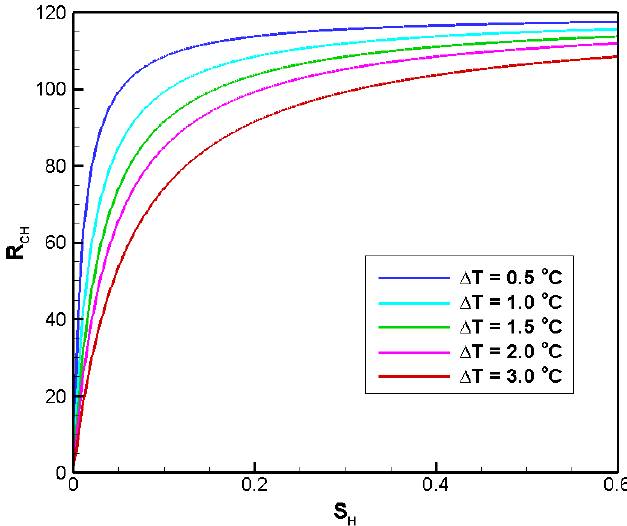
Figure 3. Dependence of heat consumption efficiency of hydrate dissociation R hydrate saturation S , and sensitivity to temperature difference Δ H